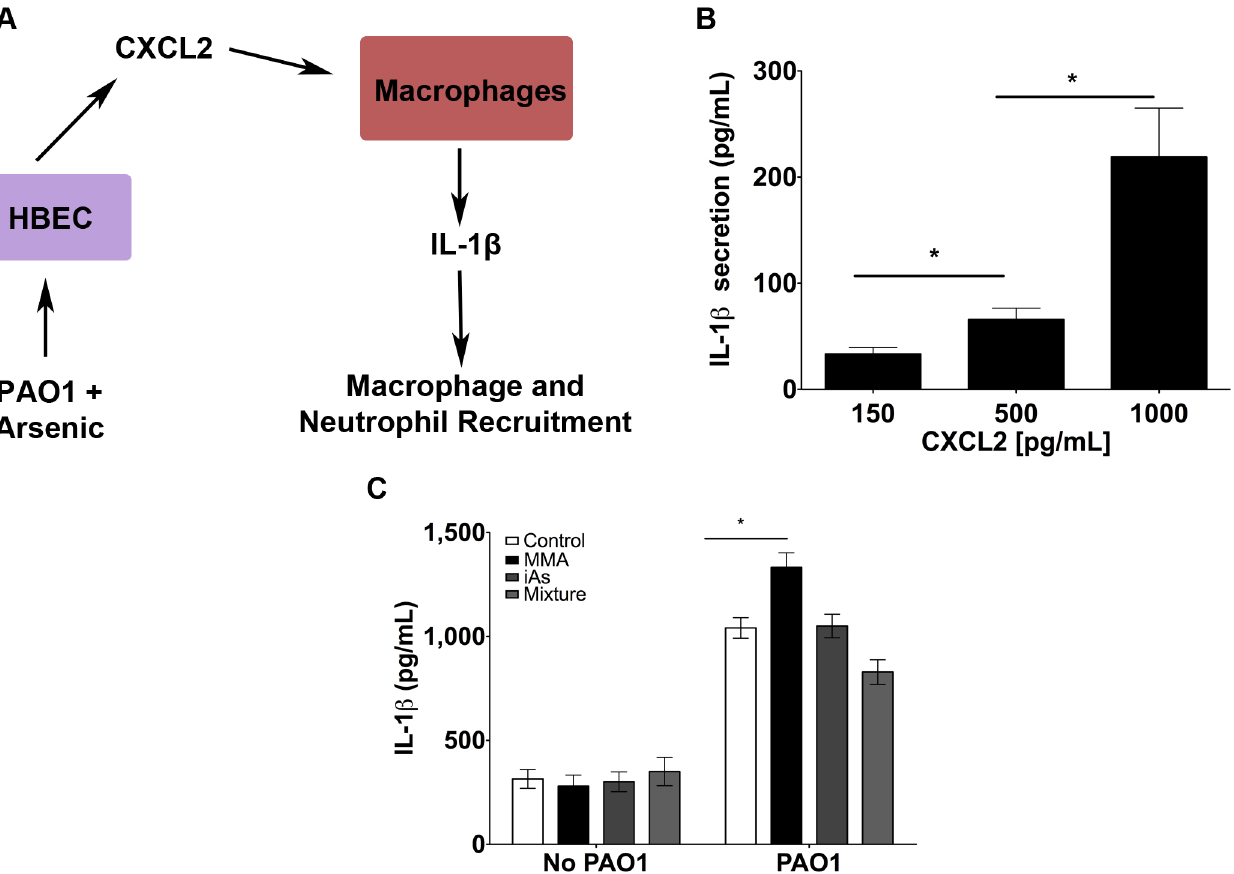
Fig 6. Changes in HBEC cytokine production impacted macrophage IL-1 β production. (A) Model of how arsenic exposure alters HBEC production of cytokines, which impacts cytokine secretion by macrophages. (B). IL-1 β secretion by THP-1 cells stimulated with purified CXCL2 using the range of concentrations released by HBEC in the present experiments. n = 4 donors. (C) IL-1 β secretion by THP-1 cells stimulated with conditioned media from HBEC treated with vehicle (control), 10 ppb MMA, 10 ppb iAs or 10 ppb total arsenic ± P . aeruginosa . n = 3 donors. * p = < 0.05 for the indicated